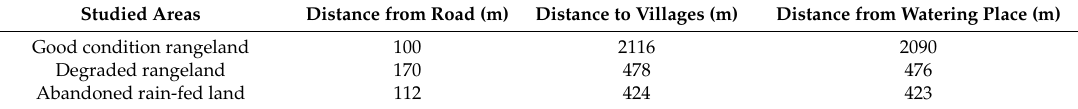
Table 3. Distance from roads, villages, and watering place in the studied